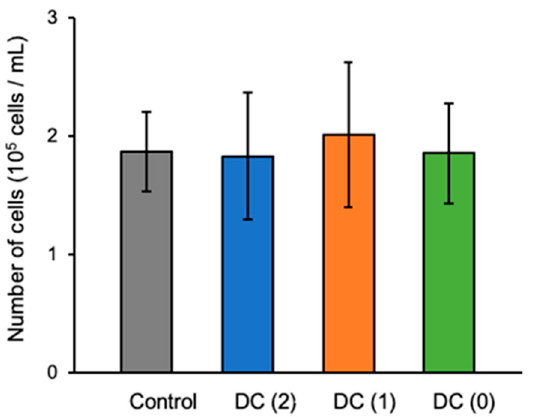
Figure 3. The final cell density of differentiated islet-like cells in each culture’s conditions. Data represent mean ± SD of n = 5–6 from two independent experiments.